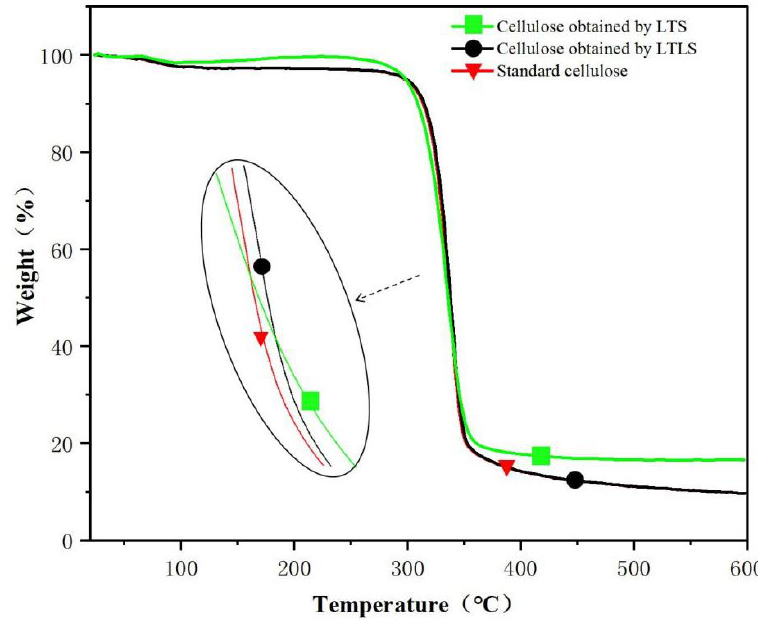
Figure 2. TG curves of LTS and LTLS products and standard cellulose.